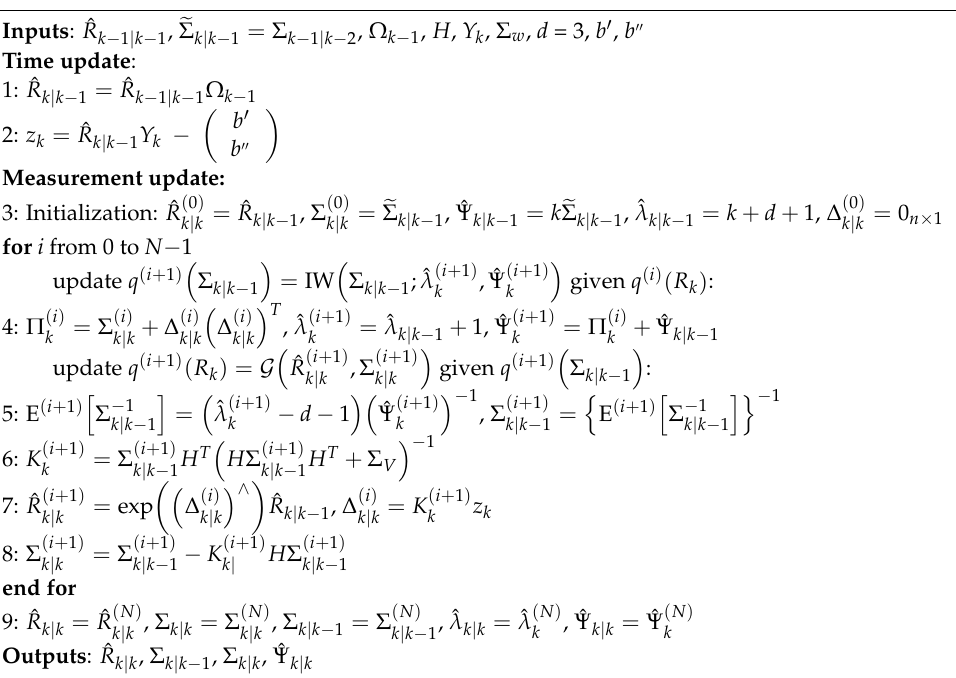
Algorithm 1. The filtering steps of one time instant in the proposed approach to attitude